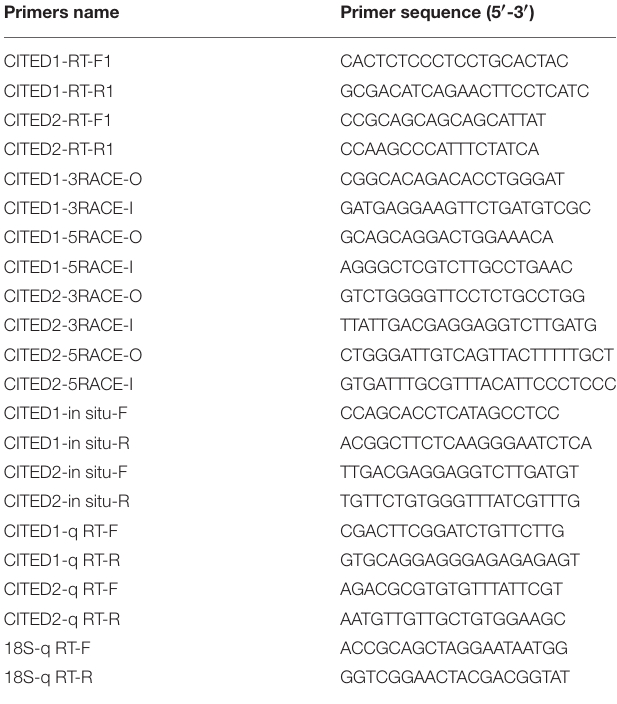
TABLE 1 | Primer sequences used in this